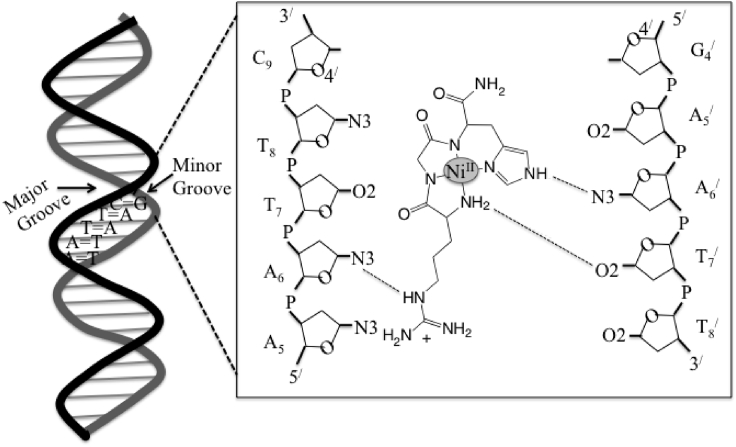
Two-Dimentional Representation of Interaction between NiII-RGH and the Minor Groove of Model DNA, 5/-d(CGCG4A5ATTCGC9G)2 through H-Bonding (Dotted Lines)(Modified from Fang et al., 2004).